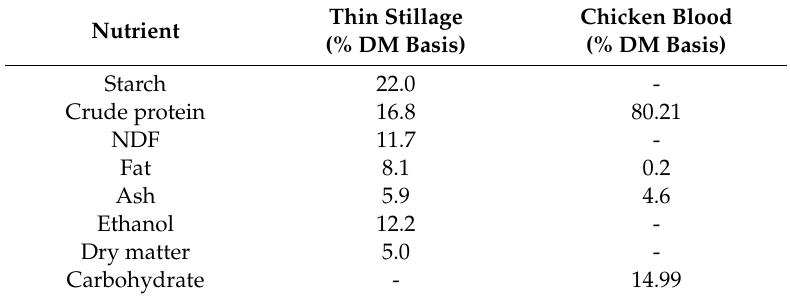
Table 1. Thin stillage and chicken blood compositions utilized to conduct the simulations, adapted from values published by [17,38,39]. Thin Nutrient